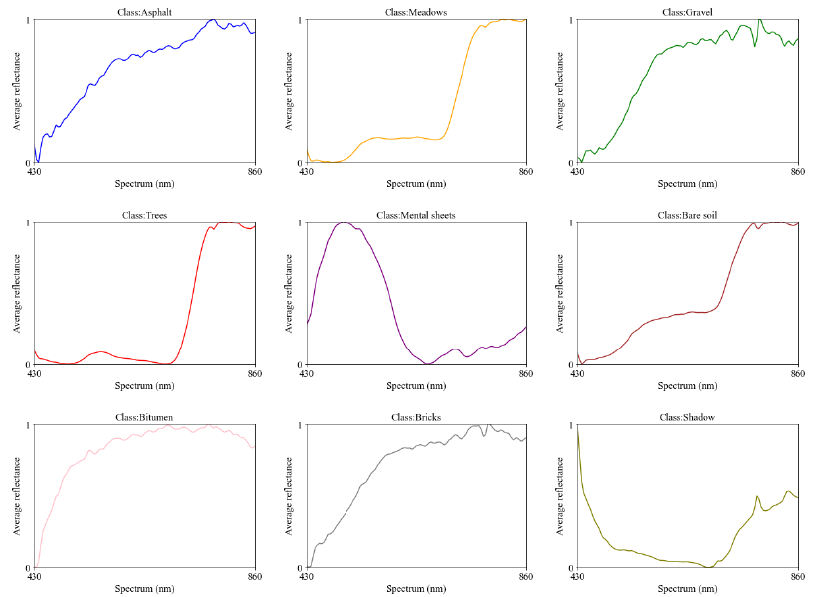
Figure 10. The average spectrum reflectance curves of different classes on the Pavia University da- taset.